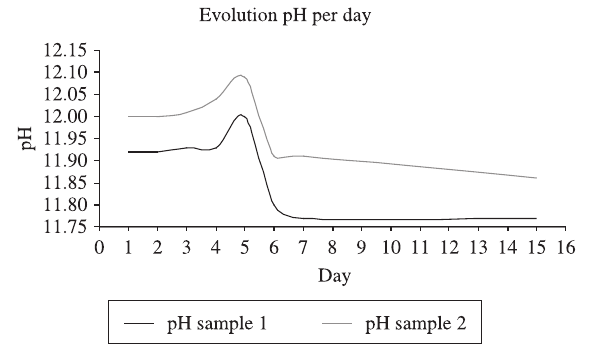
Figure 1. Variation of pH in the aliquots of samples 1 and 2 Table 1. pH of the aliquots of sample 1. Sample 1